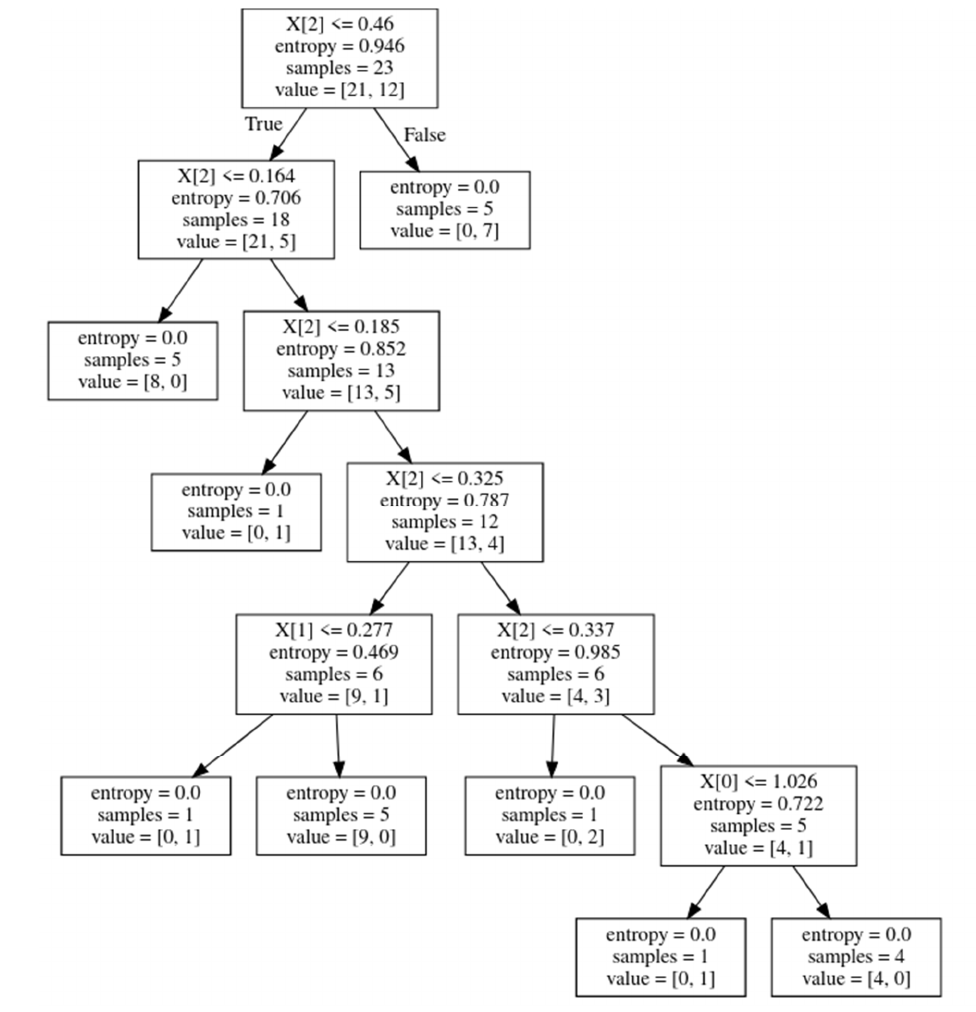
Figure 12. Sample tree 3, where X [0] is AP, X [1] is ML, and X [2] is area under the square.